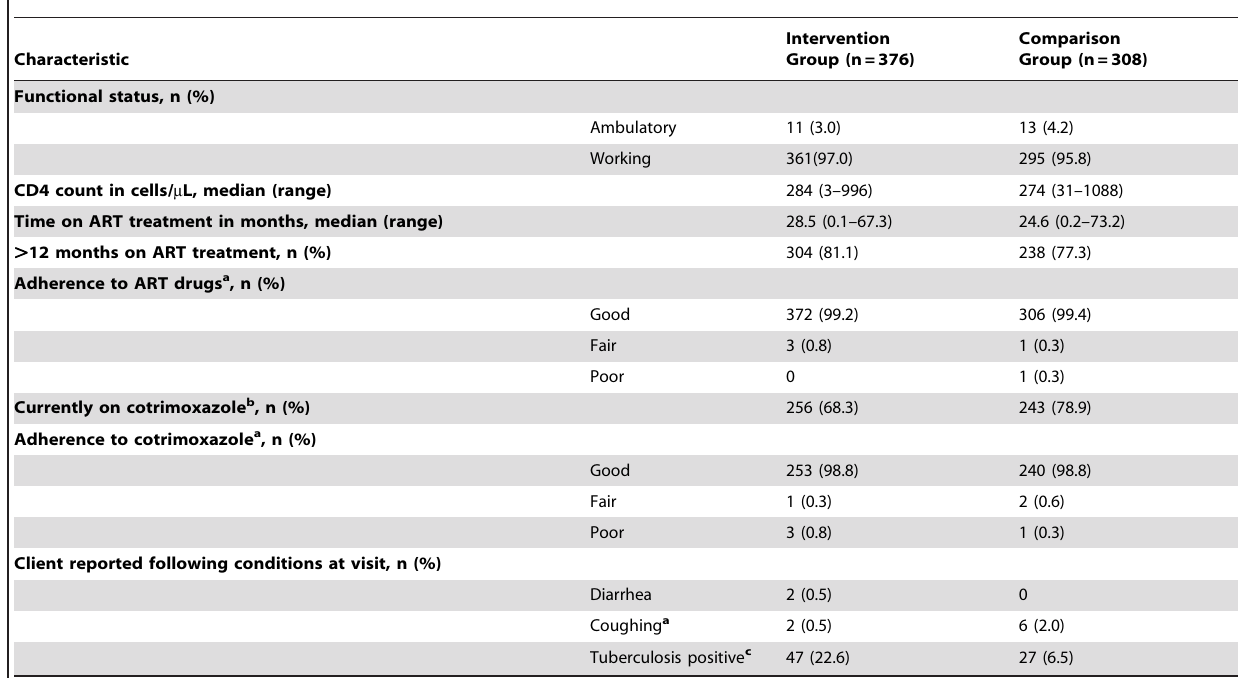
Table 2. Clinical characteristics and treatment of ART clients at baseline, by study group, basic care package evaluation, Gonder and Debre Markos, Ethiopia, October